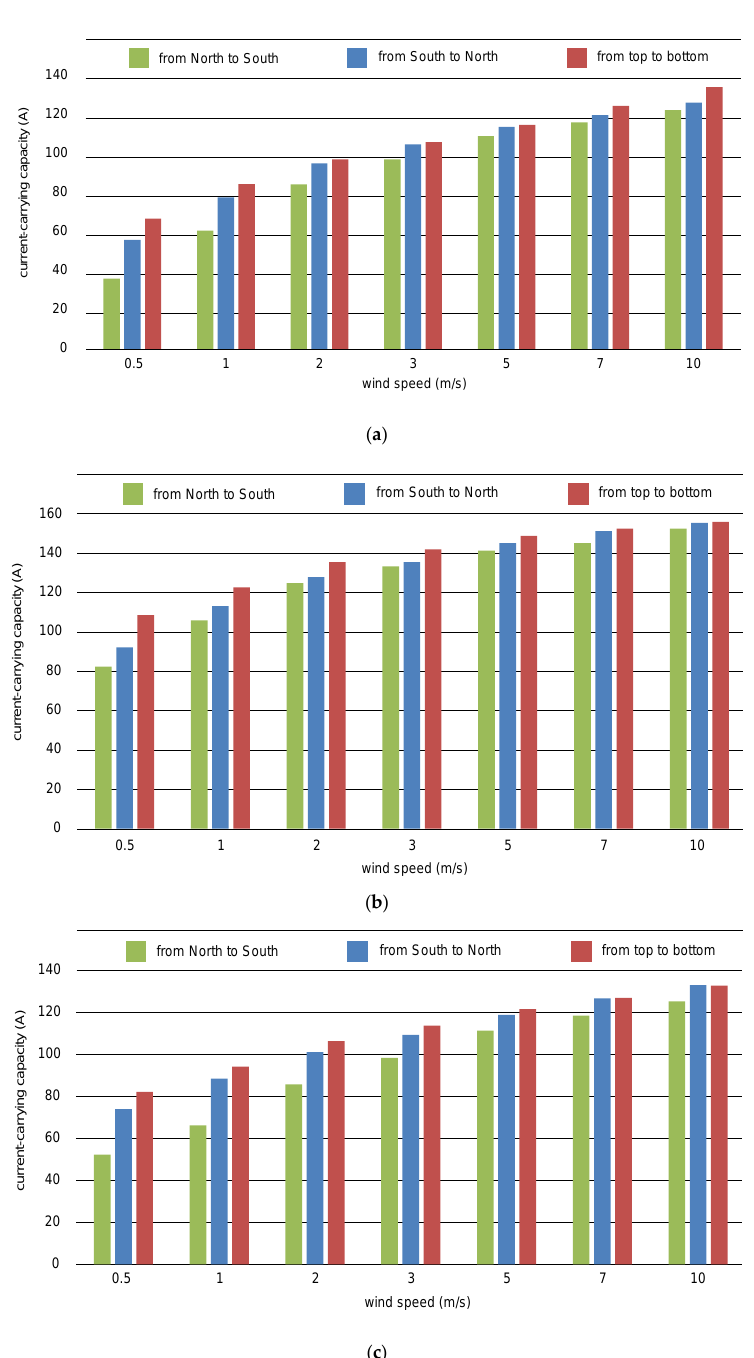
Figure 5. Effect of the wind direction and speed on the power cables current-carrying capacity, for the layouts of the power cables presented: ( a ) in Figure 4a (flat formation without spacing, ambient air temp. 30 °C); ( b ) in Figure 4b (flat formation with spacing 50 mm, ambient air temp. 30 °C); ( c ) in Figure 4c (trefoil formation without spacing, ambient air temp. 30 °C).